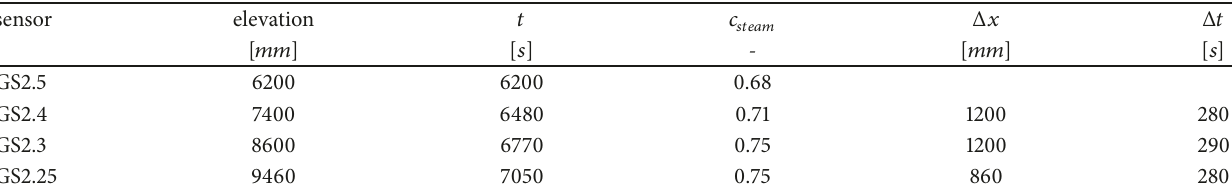
Figure 7: Steam content in Vessel 4 for experiment HP6 1. Table 1: Characteristic data to calculate the flow rate at different